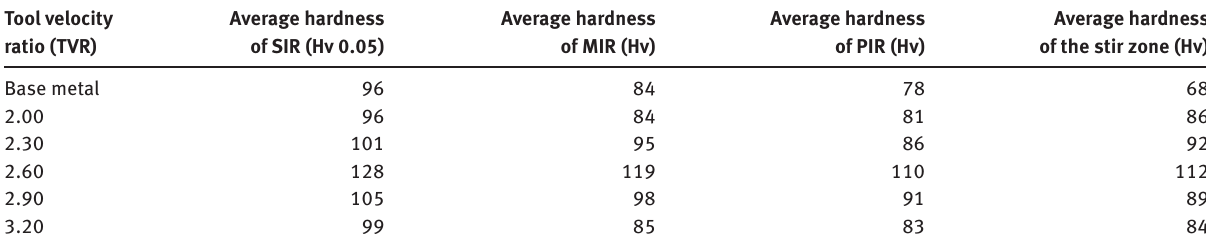
Table 7: Effect of TVR on hardness of the FSPed